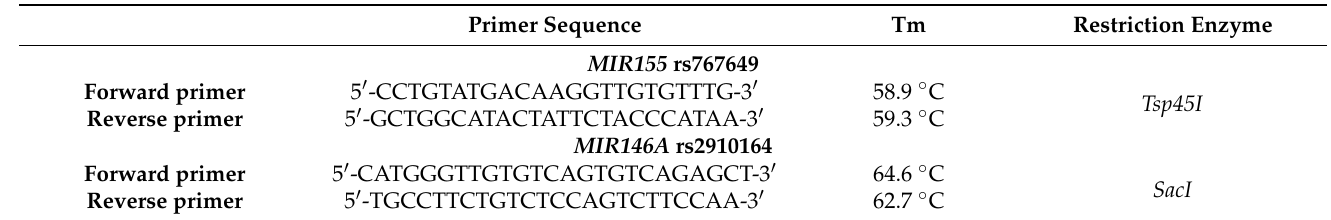
Table 1. Forward and reverse primer sequences and restriction enzymes for the MIR155 rs767649 and